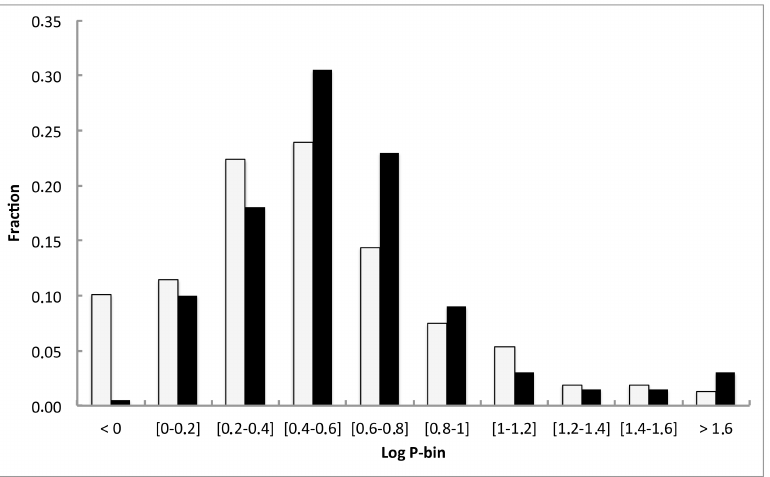
Figure 4. Observed distribution of orbital periods for 376 Algols (grey) as compared to simula- tion